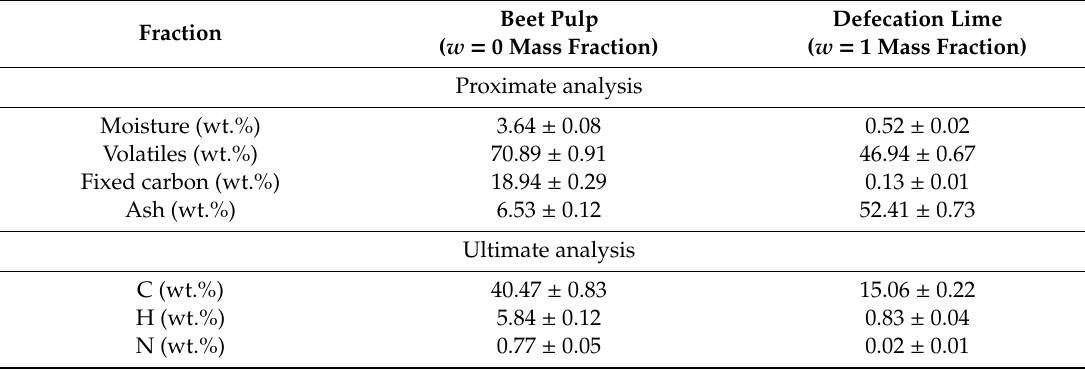
Table 1. Proximate and elemental analyses of dried beet pulp and defecation lime (average value ± standard deviation of three